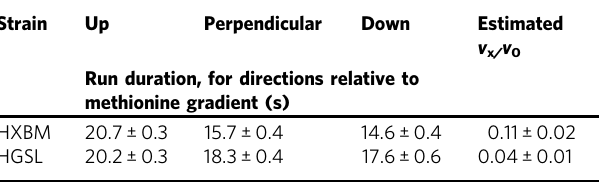
Table 1 Summary of experimental chemotaxis results.